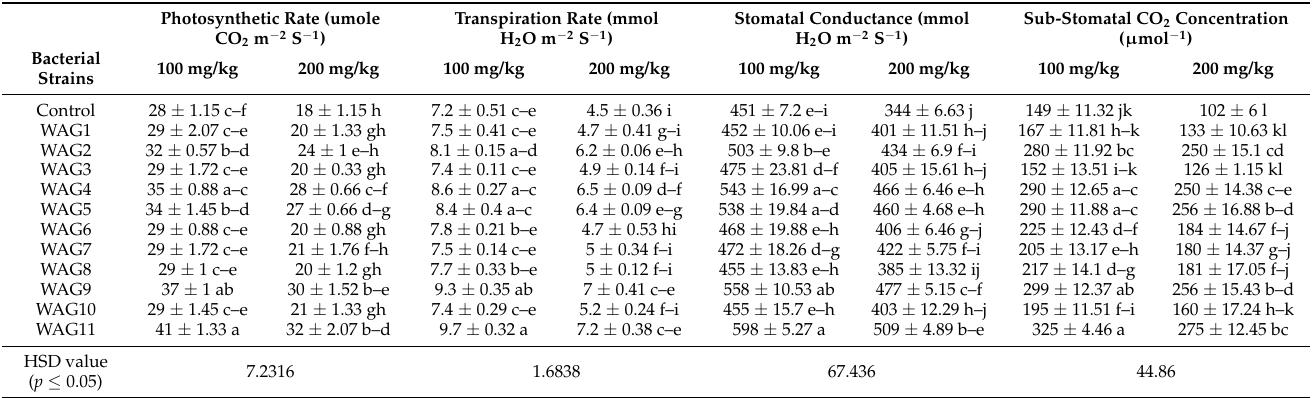
Table 5. Effect of isolated bacterial strains on gas exchange parameters of maize plants in glyphosate- spiked